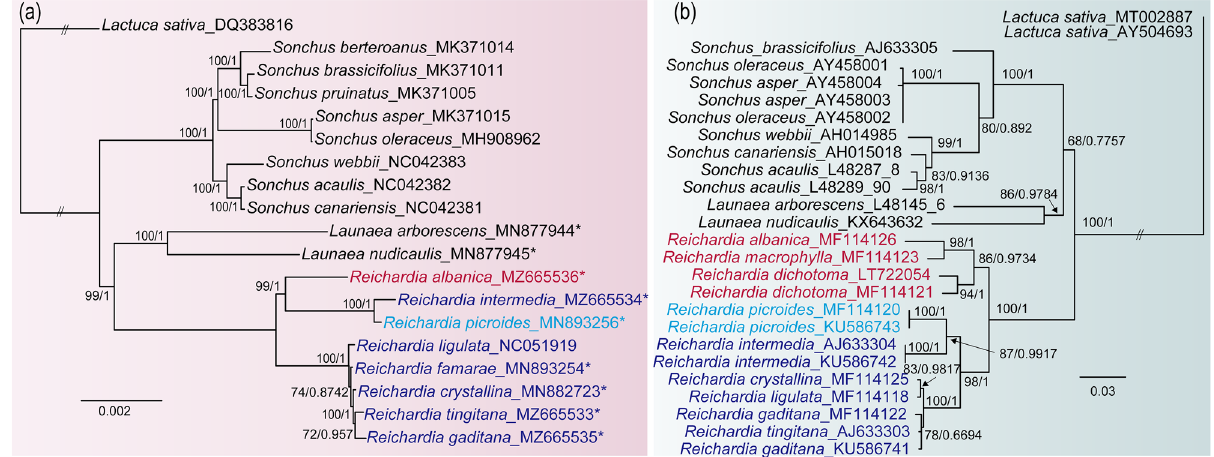
Figure 7. Maximum likelihood (ML) tree of Reichardia and closely related Launaea and Sonchus species based on ( a ) the complete plastome and ( b ) nrDNA ITS sequences. Support values are provided above and below branches (ML bootstrap value with 1000 replicates on the left and Bayesian Inference posterior probabilities on the right). “//” indicates that the branch lengths between outgroup and ingroup taxa are shortened to improve readability of trees. Newly sequenced nine chloroplast plastid genomes in this study are marked with an asterisk (*). Within Reichardia , the species with same chromosome numbers are colored in red for n = 9, navy blue for n = 8, and aqua blue for n = 7 chromosomes.